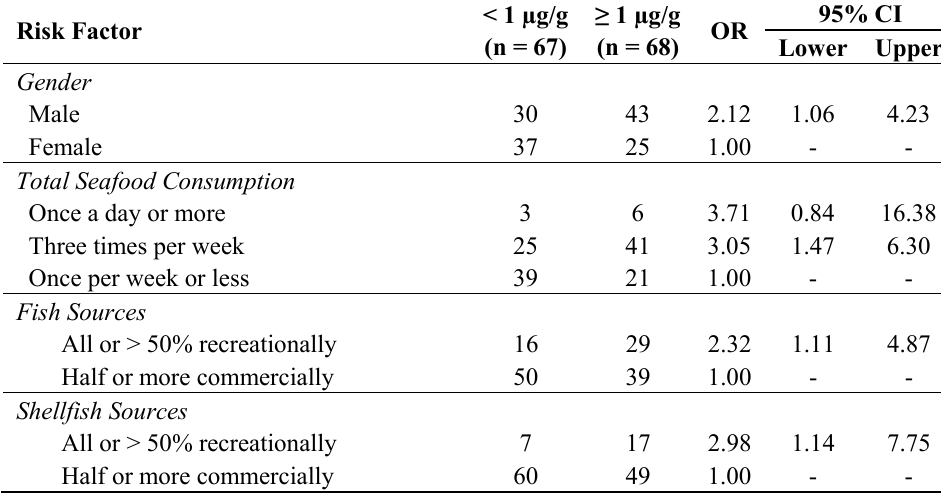
Table 5. Risk estimates (OR and 95% CI) for hair mercury concentration <1.0 vs. ≥ 1.0 µg/g for gender, total seafood consumption and sources of